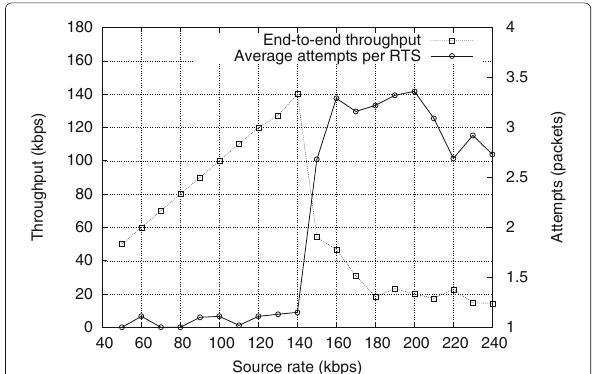
Fig. 5 End-to-end throughput and the average attempts per RTS at the source